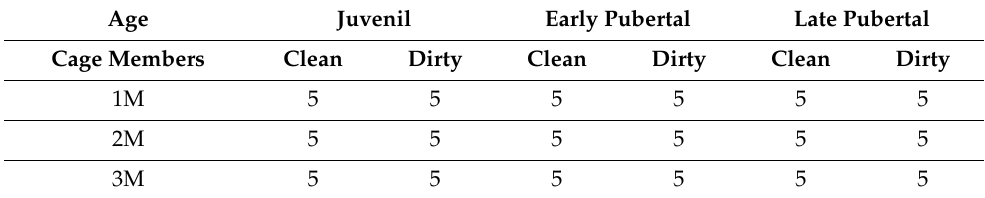
Table 1. Experimental